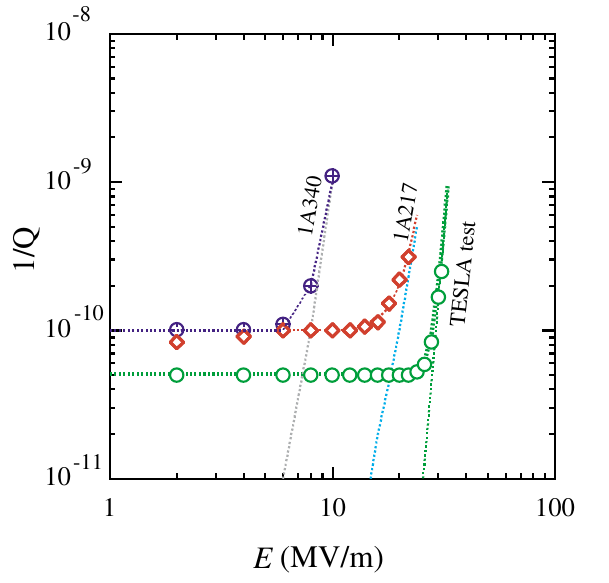
FIG. 26. (Color) SCRF cavity losses from Ref. [1].